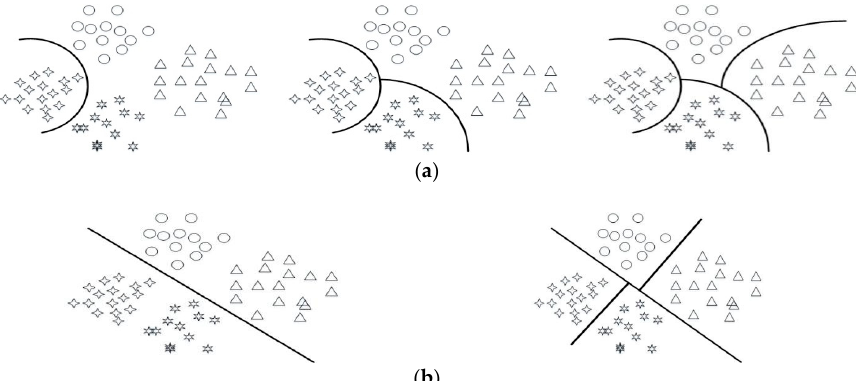
Figure 9. Multi-class model diagram. ( a ) Binary tree classification model; ( b ) Secondary classification model.